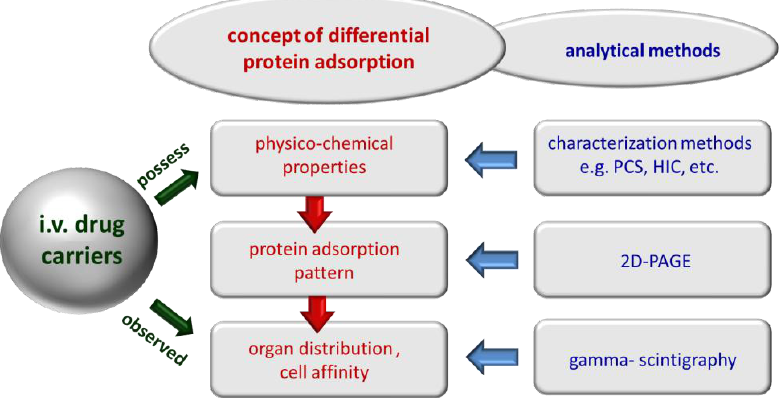
Figure 1. Concept of differential protein adsorption: the physico-chemical properties determine the composition of the protein adsorption pattern; the adsorbed proteins determine the subsequent organ distribution (modified after